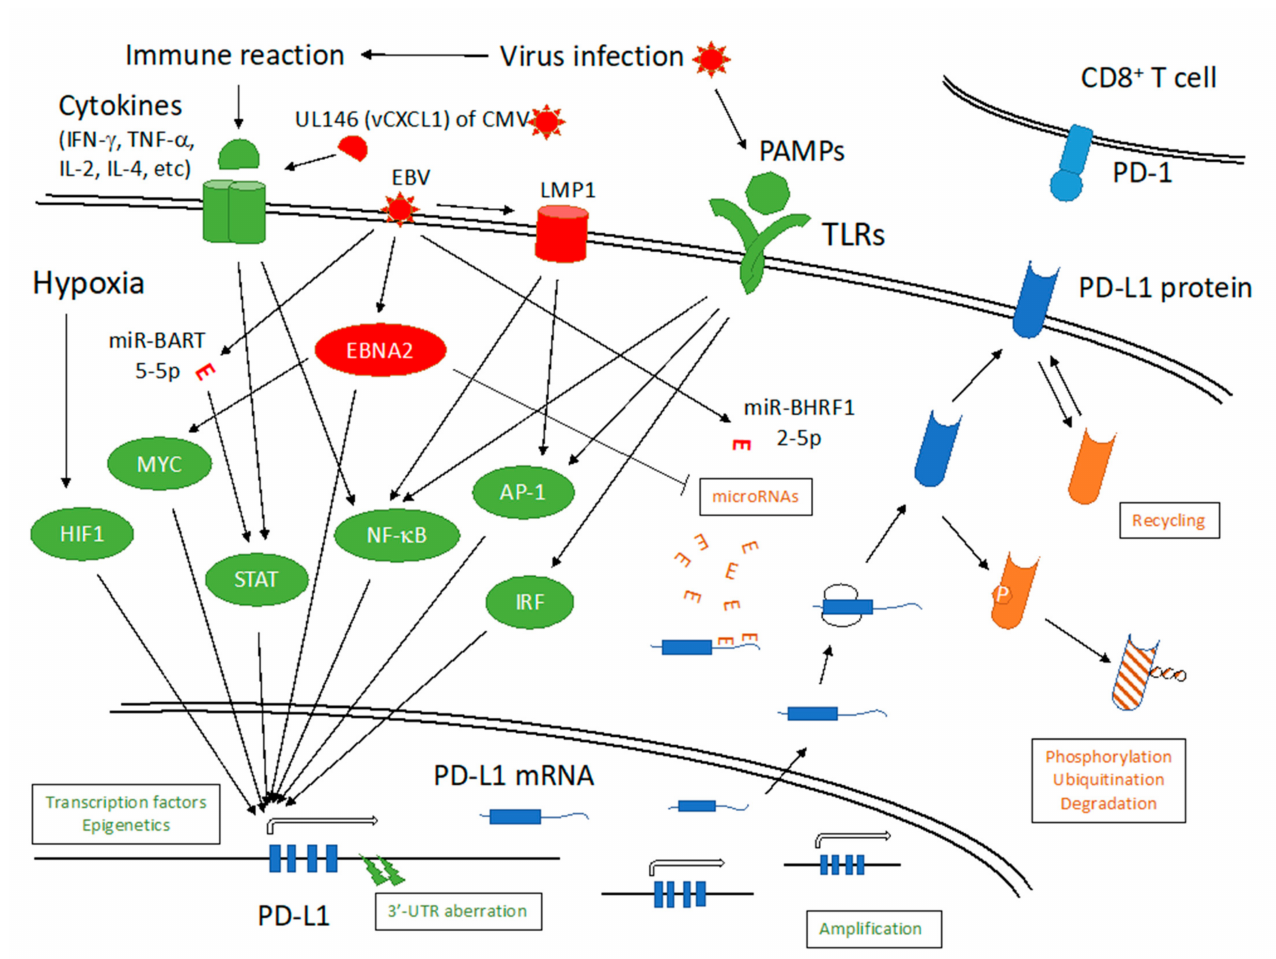
Figure 1. Schematic diagram of regulation of programmed cell death ligand 1 (PD-L1) gene expression. Green color indicates positive regulators, while orange denotes negative regulators. Red color indicates viral factors. IFN- γ , interferon- γ ; TNF- α , tumor necrosis factor- α ; IL-2, interleukin-2, CMV, cytomegalovirus; UL146, unique long 146; vCXCL1, viral chemokine (C-X-C motif) ligand 1; EBV, Epstein–Barr virus; LMP1, latent membrane protein 1; PAMPs, pathogen-associated molecular patterns; TLRs, toll-like receptors; HIF1, hypoxia-inducible factor 1; MYC, myelocytomatosis oncogene; STAT, signal transducer and activator of transcription; NF- κ B, nuclear factor- κ B; AP-1, activator protein 1; IRF, interferon regulatory factor, miR-BHRF1-2-5p, microRNA- Bam HI H fragment rightward frame